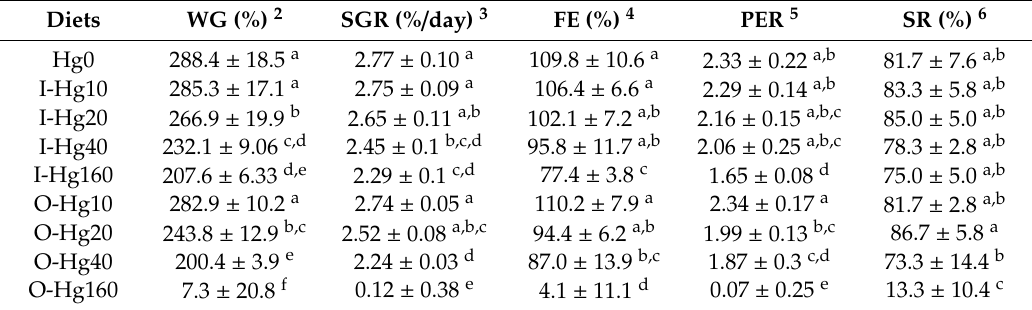
Table 2. Growth performances of juvenile olive flounder, Paralichthys olivaceus, fed nine experimental diets for eight weeks 1.